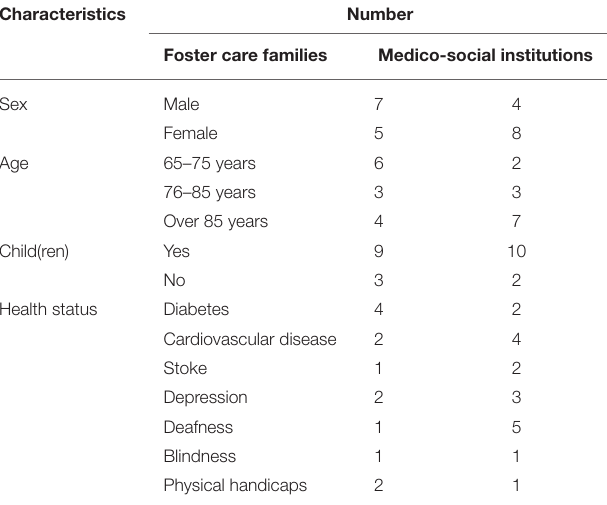
TABLE 3 | Participant